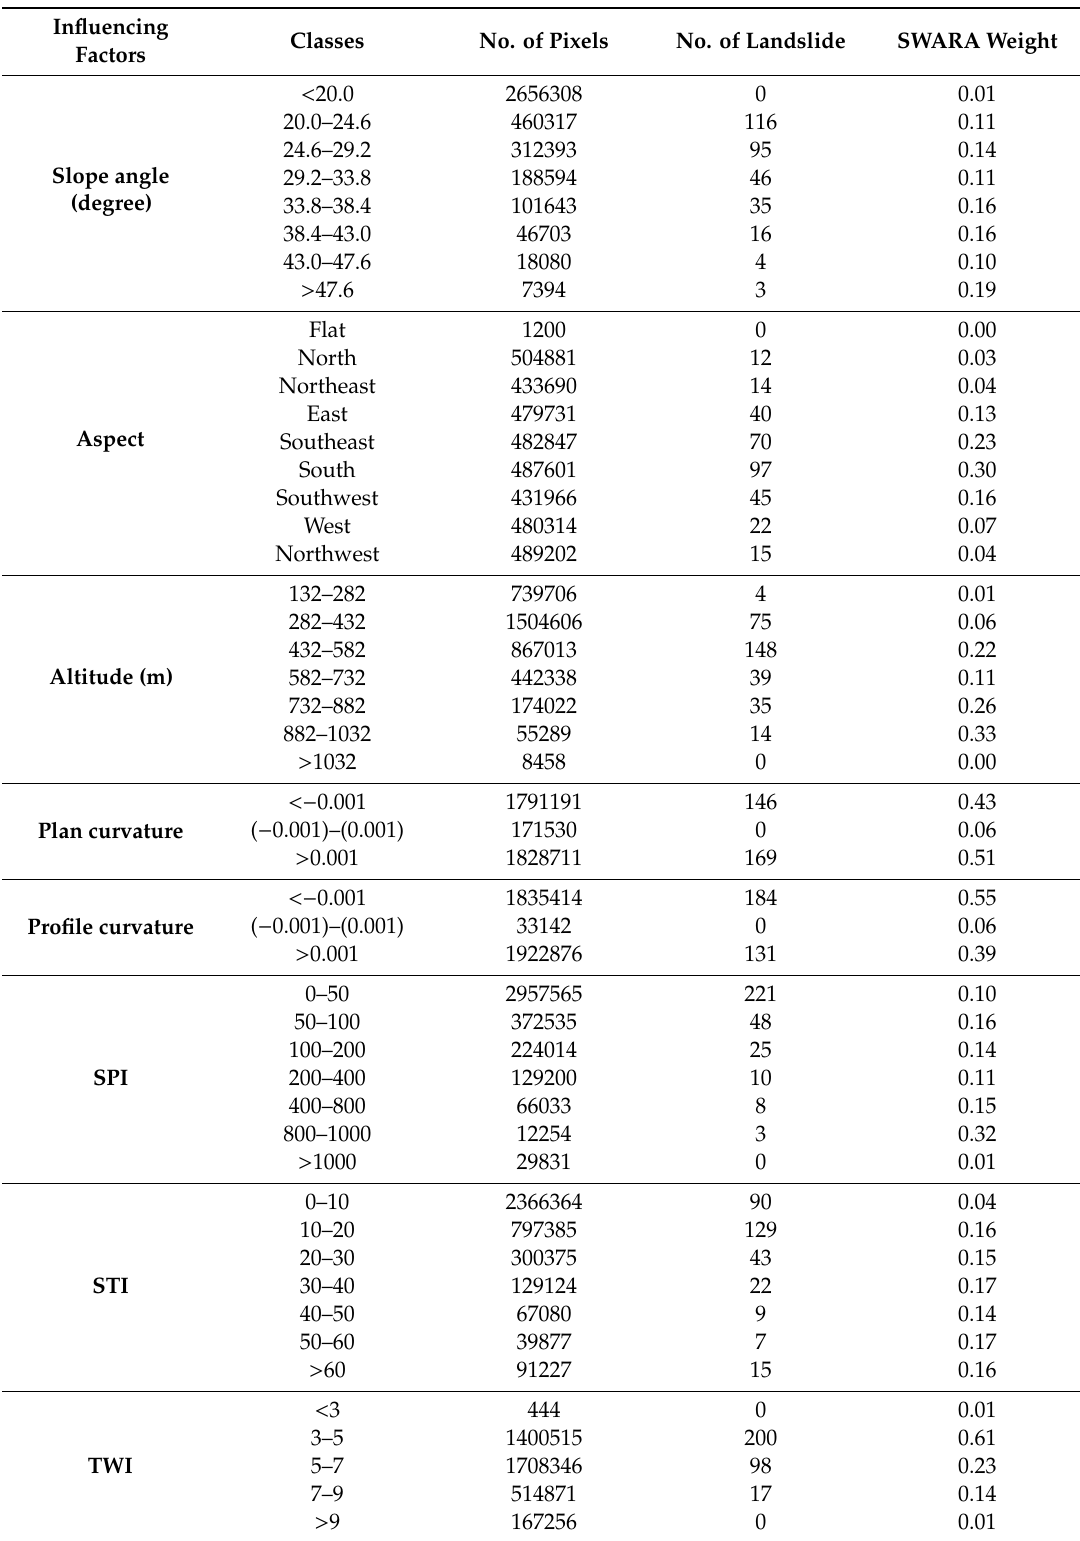
Table 2. Spatial relationship between landslides and influencing factors by the step-wise weight assessment ratio analysis (SWARA)